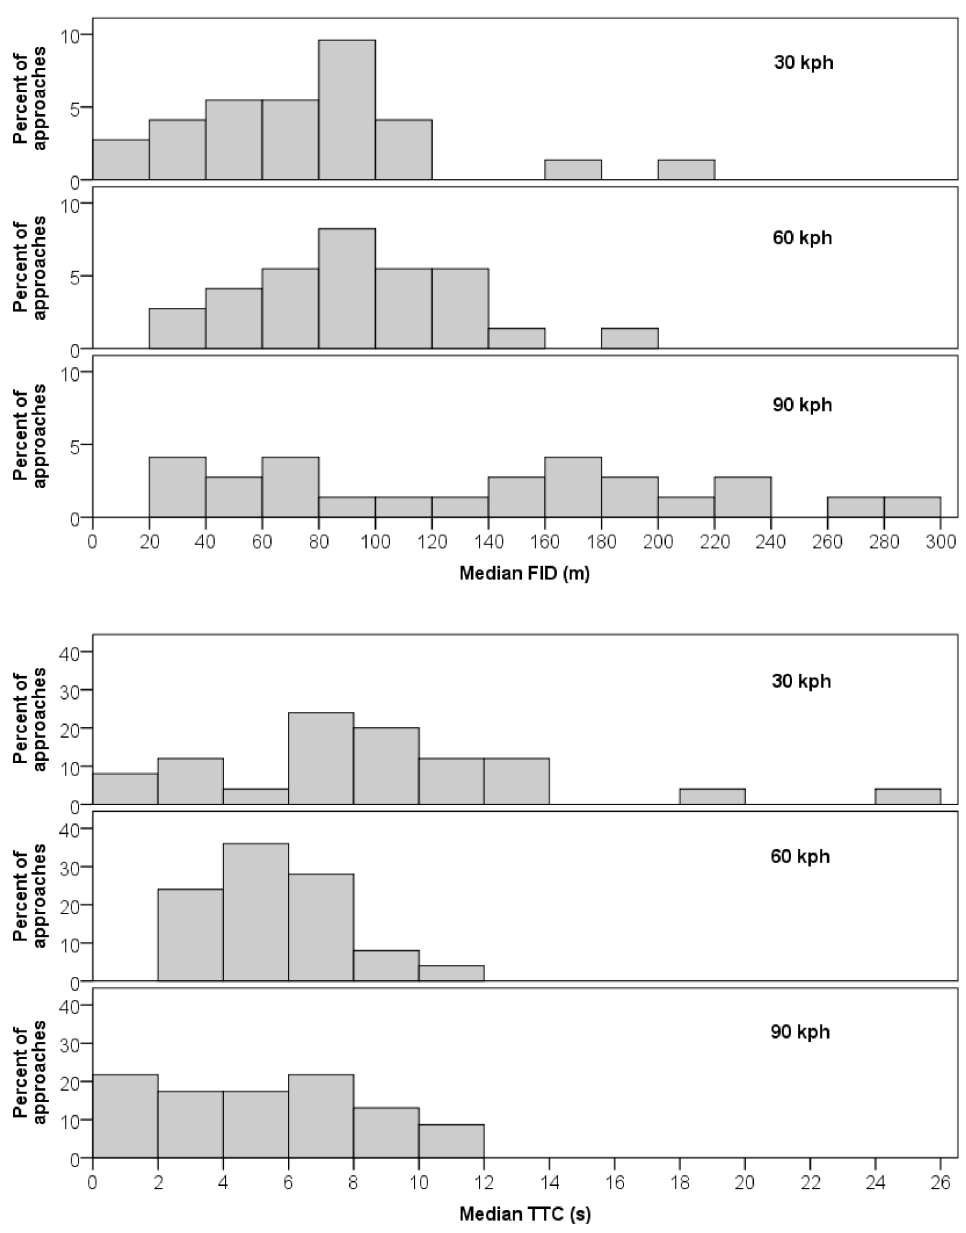
Figure 1. Frequency distributions relative to FID and TTC across 73 vehicle approaches at three vehicle speeds (approaches at 30 kph, n=25; 60 kph, n=25; 90 kph,